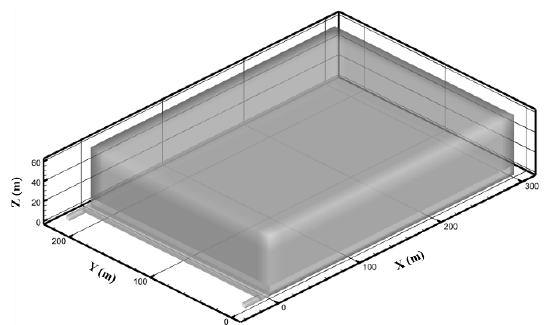
Figure 1. Model of goaf for the comprehensive working face.